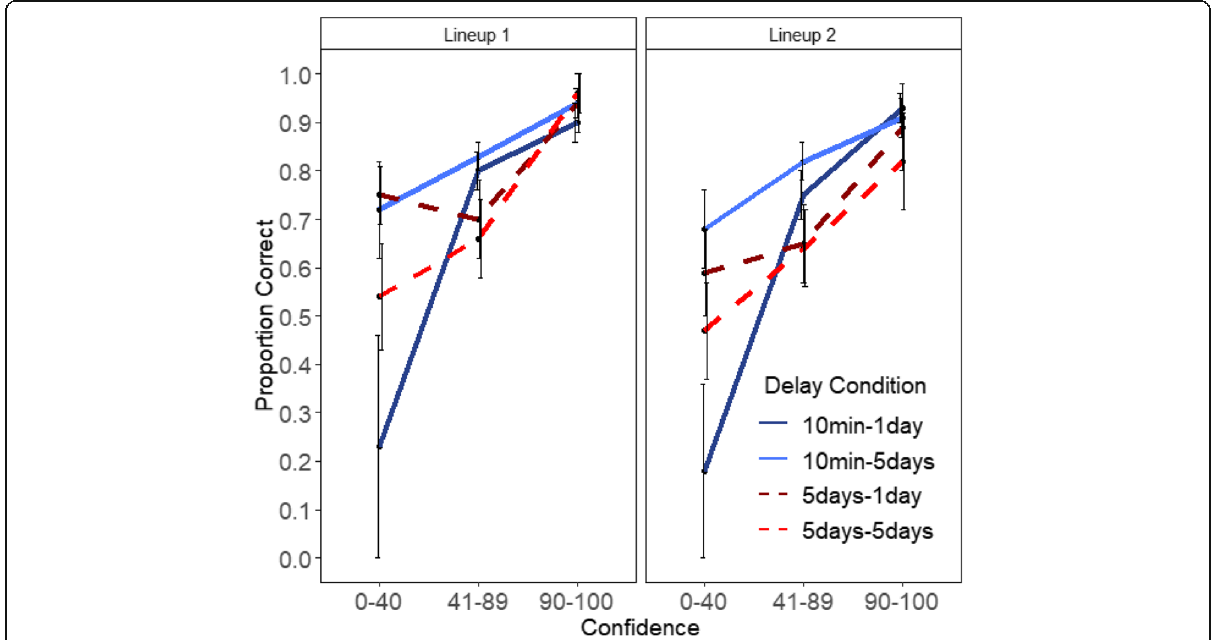
Fig. 7 Experiment 2 CAC plots for Lineups 1 and 2. Error bars are standard